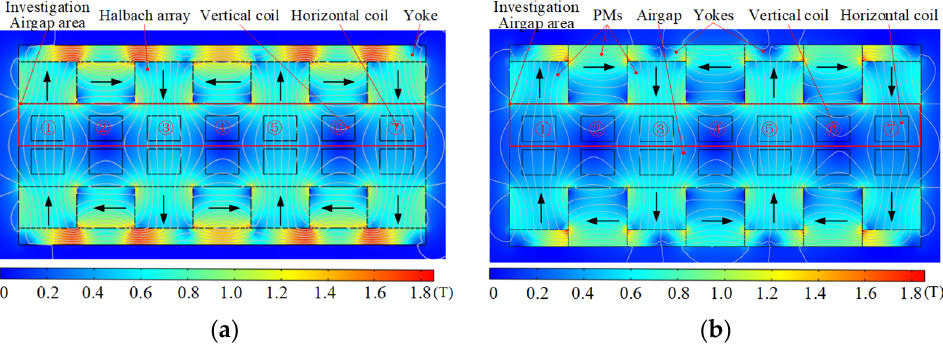
Figure 12. Flux nephogram of the 2-DOF electromagnetic actuators: ( a ) Conventional halbach array; ( b ) Improved halbach array.